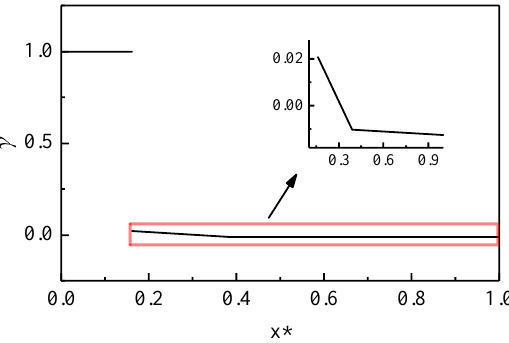
Figure 15. Weight coefficient of transverse